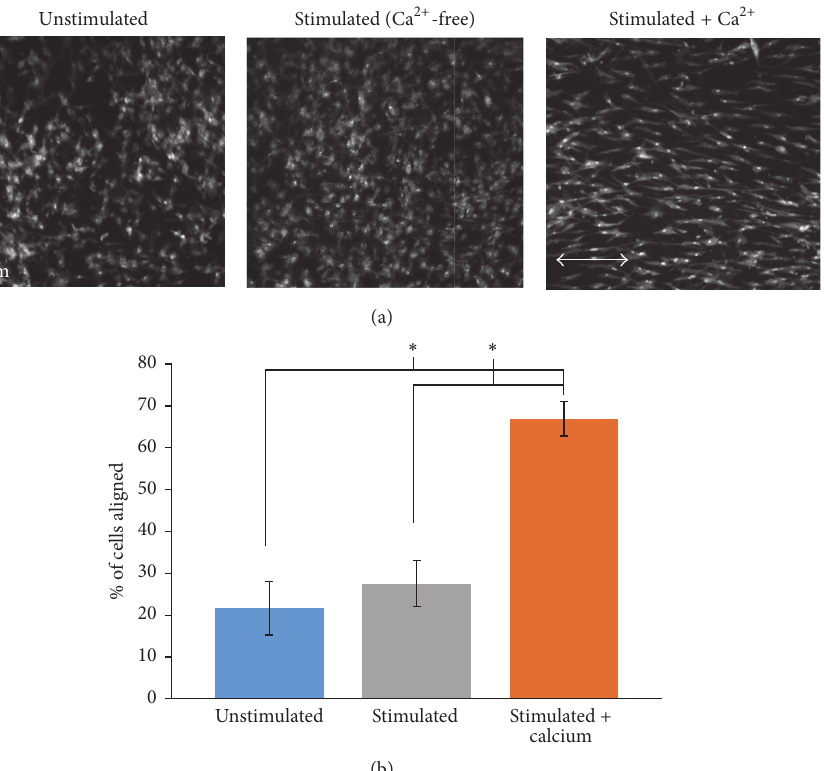
Figure 6: Electrically induced alignment of CPCs. CPCs were plated in stimulation media and subjected to electrical stimulation in culture for 72 hrs (stimulated + Ca 2+ ). As controls, CPCs were plated in stimulation media and cultured for 72 hrs without electrical stimulation (unstimulated) or in Ca 2+ -free media and subjected to electrical stimulation (stimulated). All groups were fixed, permeabilized, and incubated with fluorescein-5-maleimide. Representative images of cells from the three groups are shown in (a). Summary bar graph of cellular alignment for the three culture conditions is shown in (b). Arrow in (a) (stimulated + Ca 2+ ) is the direction of the electrical field. Data in (b) represent mean ± SD. ∗ 𝑝 < 0.05 ; Student’s 𝑡 -test; 𝑛 = 8